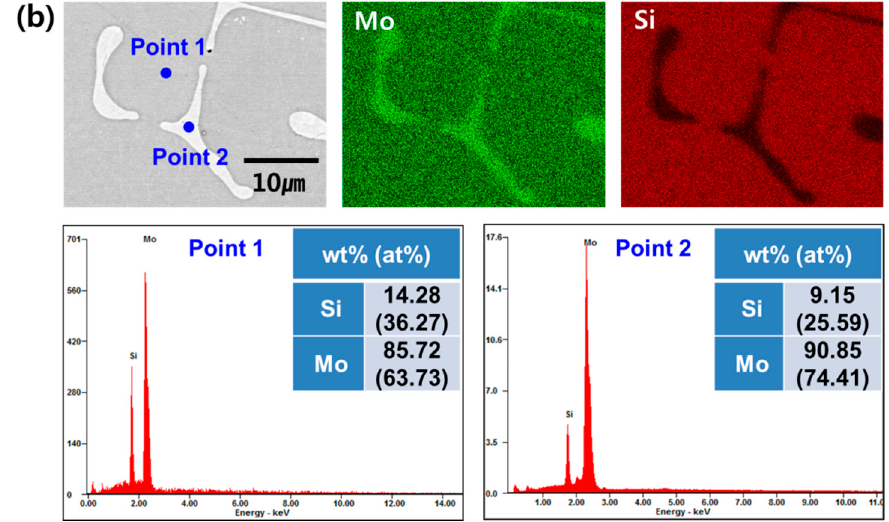
Figure 1. ( a ) The microstructure of the cast Mo 5 Si 3 ingot observed by back-scattered electron imaging, and ( b ) EDS area and point analyses result. Points 1 and 2 were determined as Mo 5 Si 3 and Mo 3 Si, respectively.